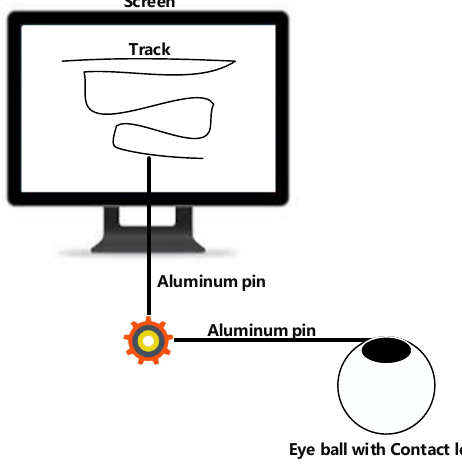
Figure 1. Invasive eye tracker [11].